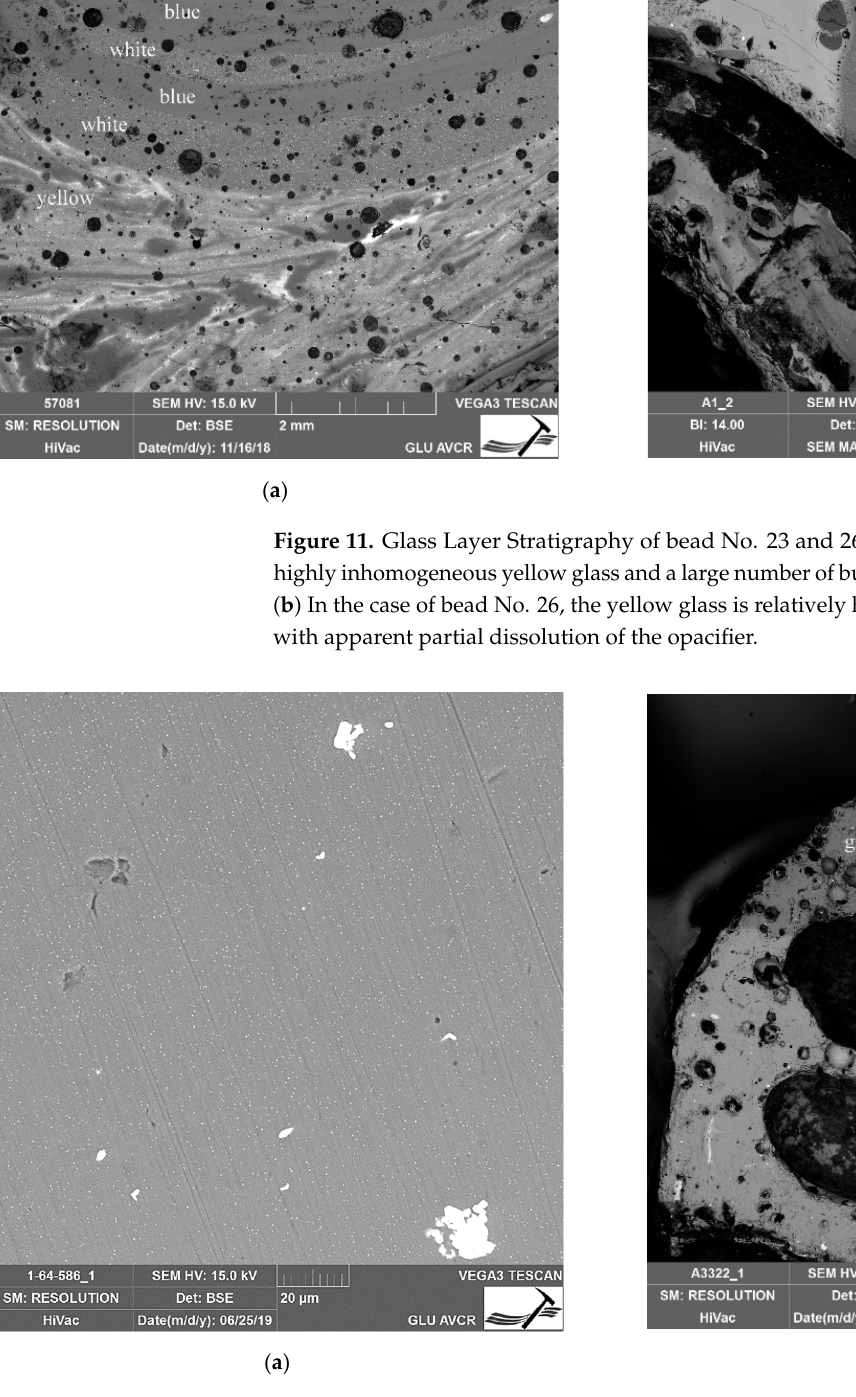
Figure 12. Structure of red beads. ( a ) Distribution of opacifiers in glass of Sample No. 33, two types of different sizes can be observed; ( b ) Heterogeneous structure of Sample No. 32, a red bead with a white (darker area at the top of the image) and green line on the surface.